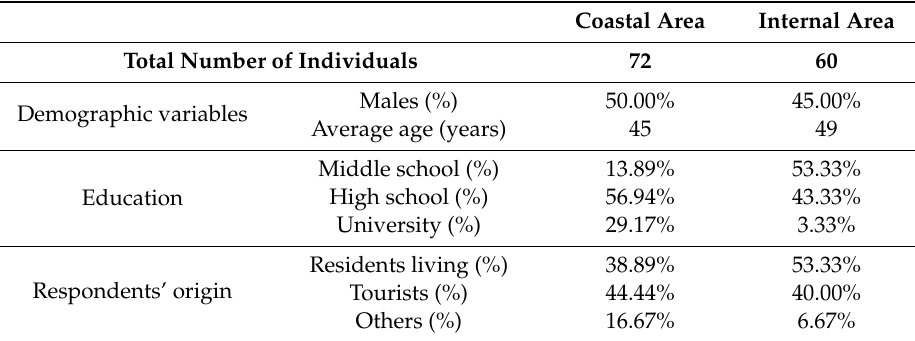
Table 10. Sample characteristics.